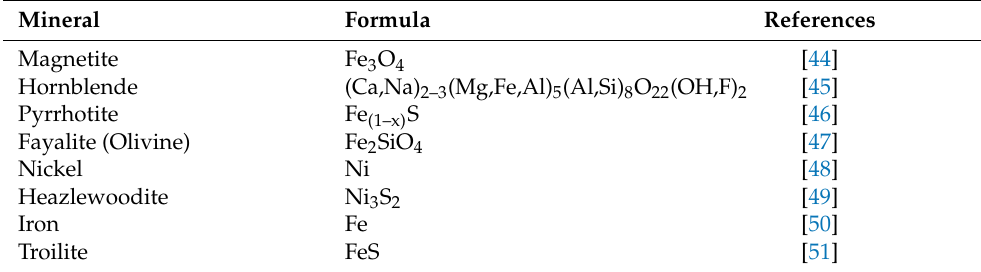
Table 4. Identified minerals in the process samples.